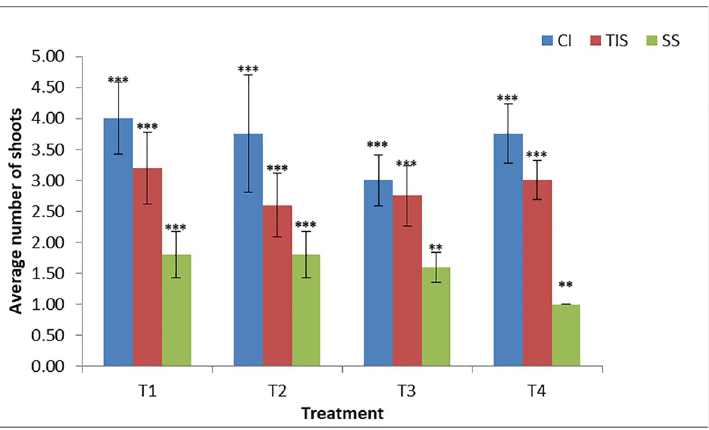
Fig 2. Treatment and culture system effect on in vitro Dioscorea rotundata . CI, Complete Immersion; TIS, Temporary Immersion System; SS, Semi-Solid.